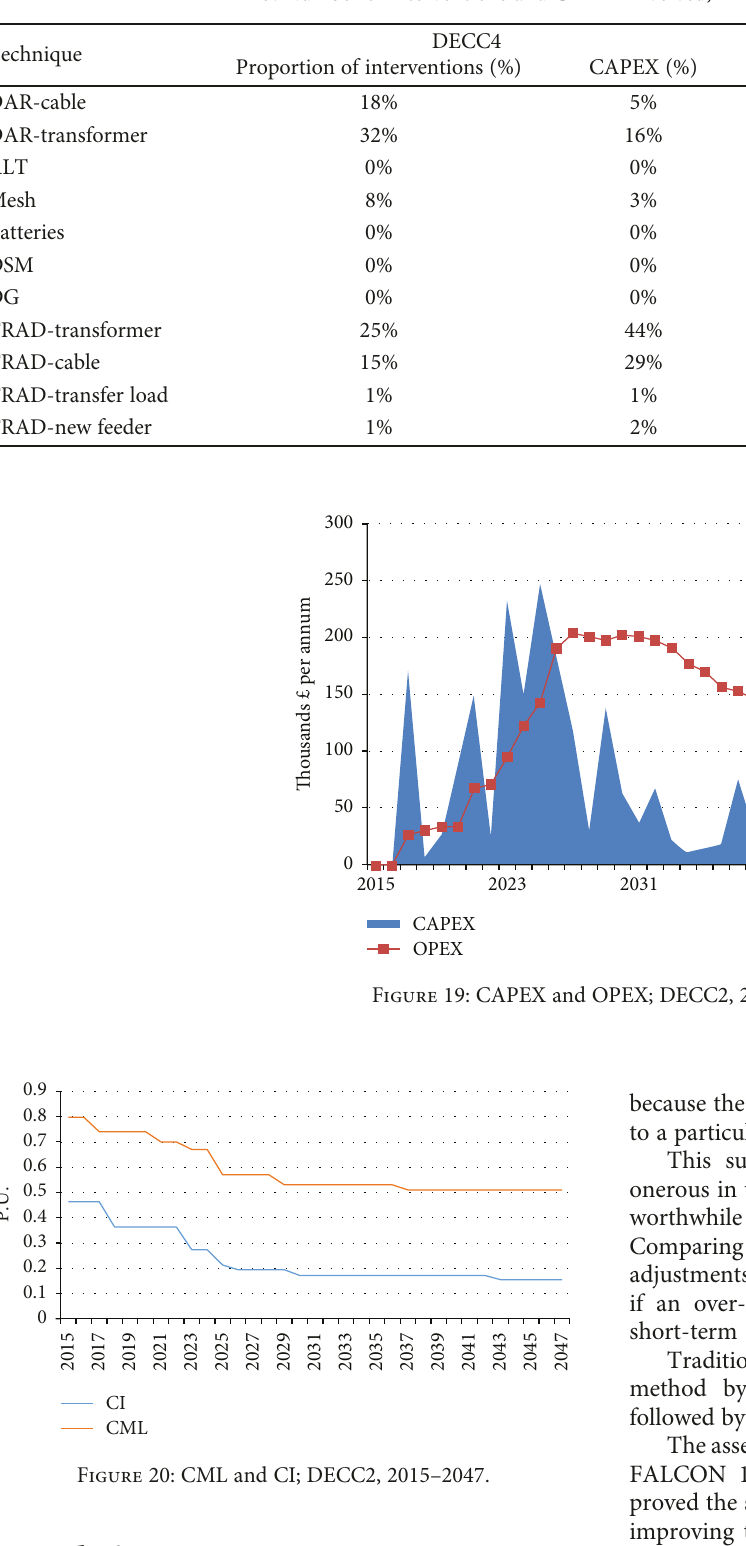
Table 3: Number of interventions and CAPEX involved; DECC4 and DECC2, 2015 – 2047.